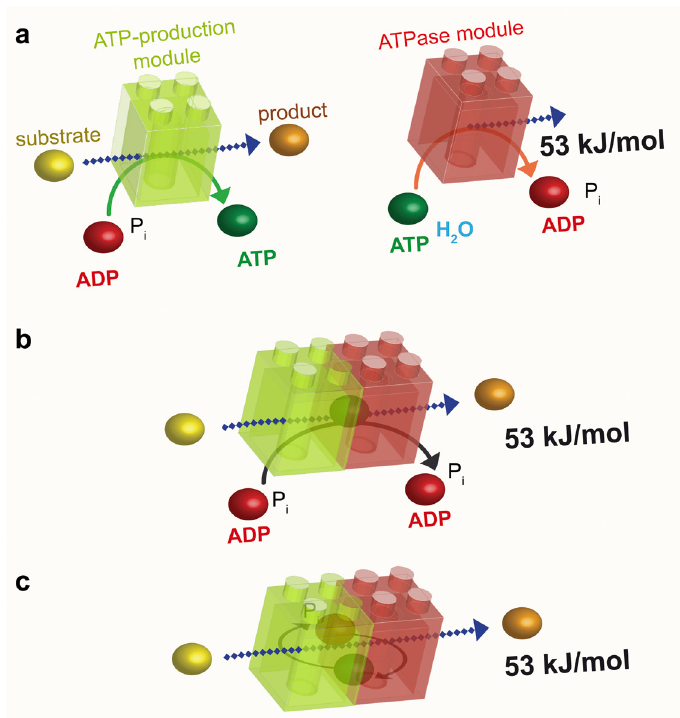
Figure 4. Energetic channeling. a : The ATP-production module (green) uses the energy of a substrate to convert ADP to ATP, whereas the ATPase module (red) uses the high energy of the phosphoryl bond of ATP to liberate 53 kJ/mol to perform a cellular function. b : As in substrate channeling (see Figure 2b), the association of these two modules results in energetic channeling of ATP from its site of production to its site of consumption without its release into the bulk phase. c : Energetic channeling may also involve ADP and P ATP, adenosine 5’-triphosphate; P , inorganic i